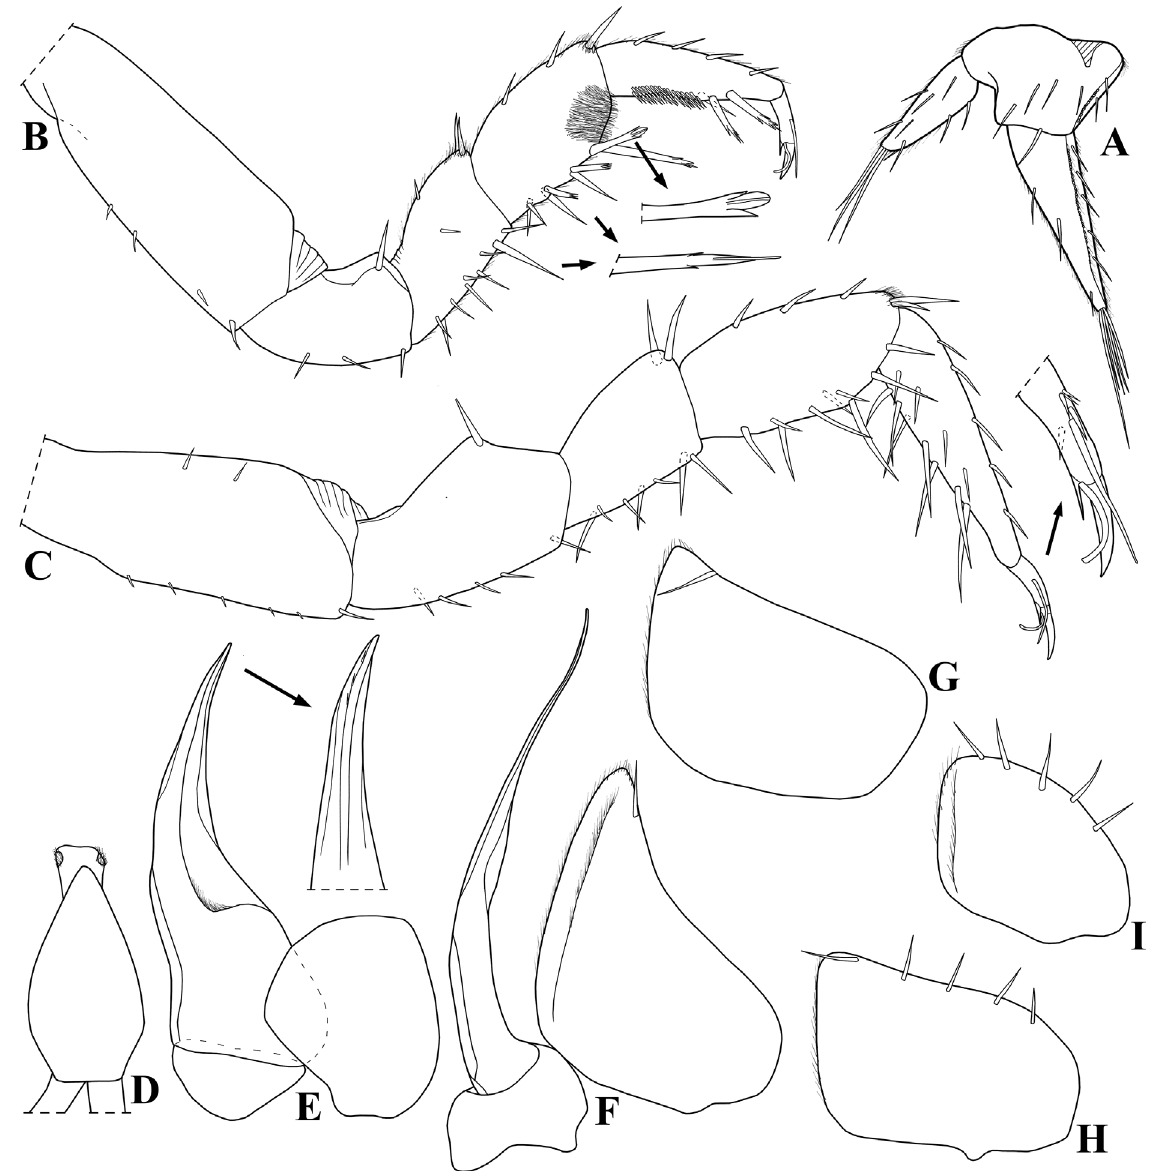
Fig. 10. Metaprosekia igatuensis Campos-Filho, Fernandes & Bichuette sp. nov., ♀, paratype (LES 6349) (A) and ♂, paratype (LES 6349) (B–I). A . Uropod. B . Pereopod 1. C . Pereopod 7. D . Genital papilla. E . Pleopod 1. F . Pleopod 2. G . Pleopod 3 exopod. H . Pleopod 4 exopod. I . Pleopod 5